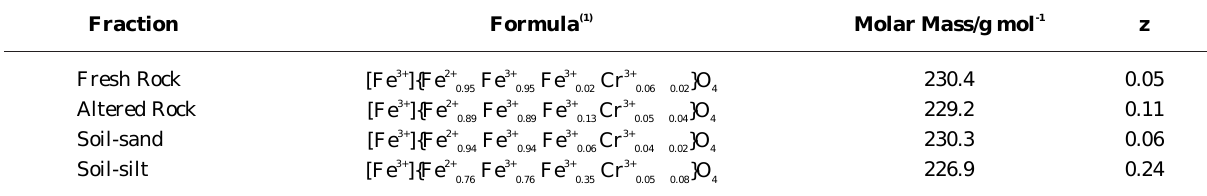
Table 6. Spinel formulae, their corresponding molar masses and degrees of non-stoichiometry (z)